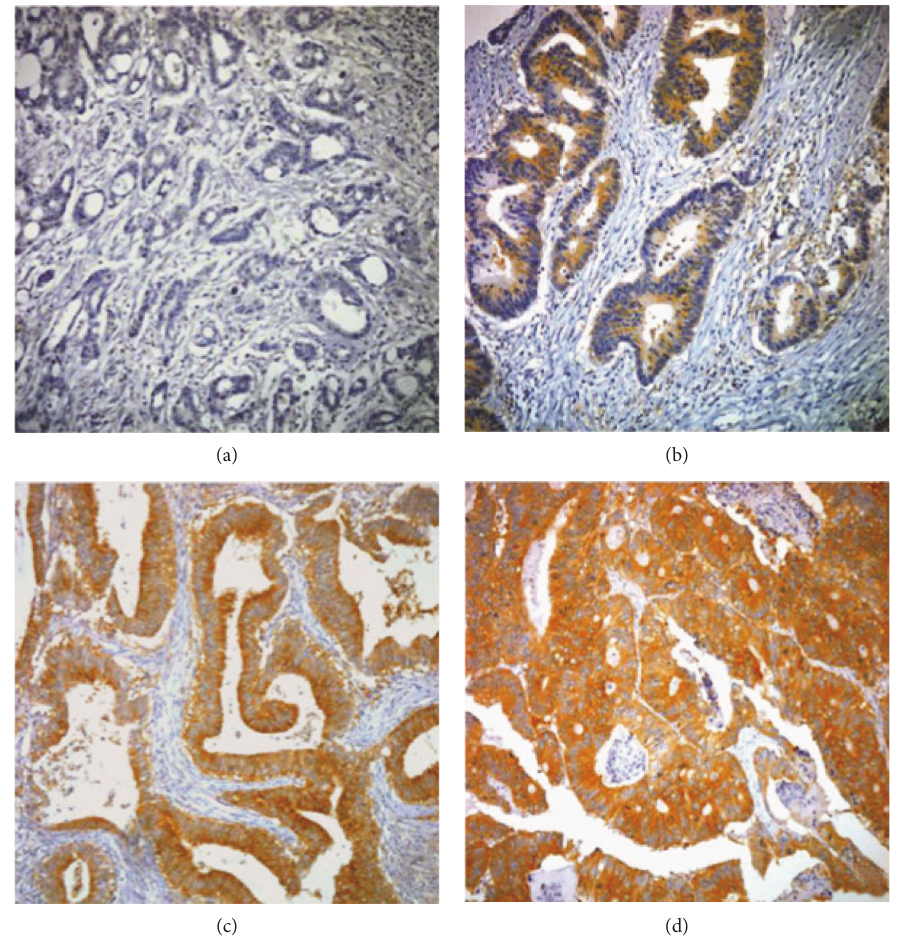
Figure 1: The microphotographs of COX-2 immunostaining by intensity in colorectal cancer: (a) negative, (b) weak, (c) moderate, and (d)